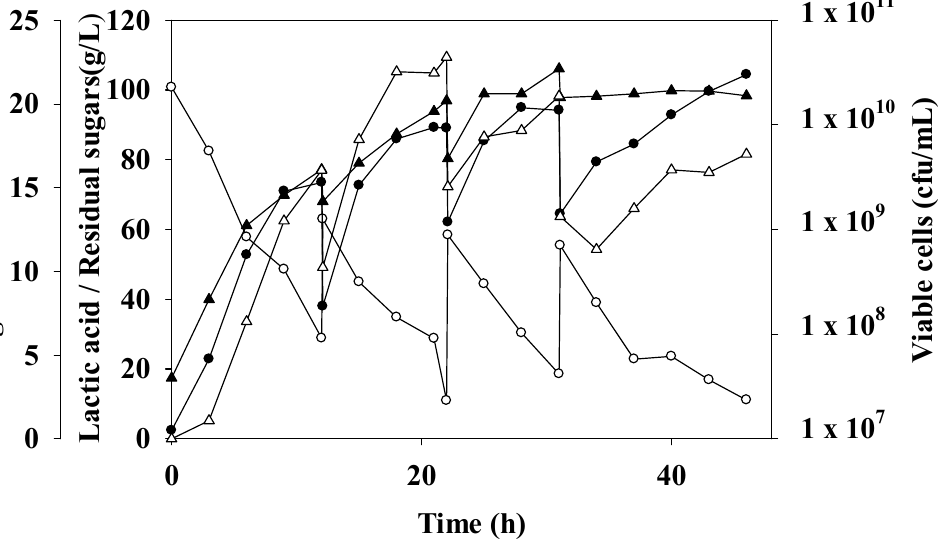
Figure 4. Fed-batch and repeated fed-batch fermentation for lactic acid production by L. rhamnosus ATCC 10863 using undiluted oil palm trunk sap with nutrient supplementation. Cells cultivated in 2 L fermenter containing 1.2 L working volume with 0.8 L OPT sap feed medium. A 0.2 L of feed medium was added at the beginning of feeding; the other was constant fed at the rate of 67.7 mL/h. Fermentation was performed at a temperature of 40 °C, agitation speed of 200 rpm, pH 6.5. Lactic acid ( ● ), residual sugars ( ○ ), viable cells ( ▲ ), and cell growth at OD 620 nm ( ∆ ) was indicated.